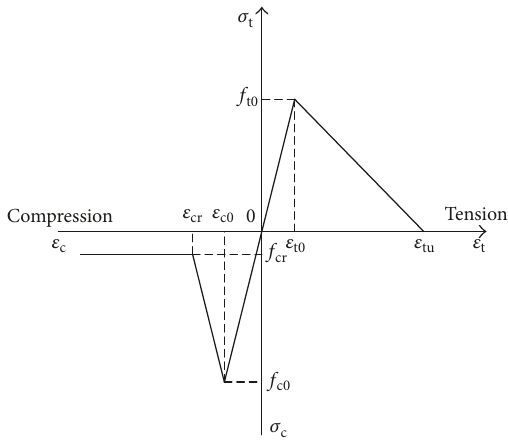
Figure 2: Dynamic damage model for